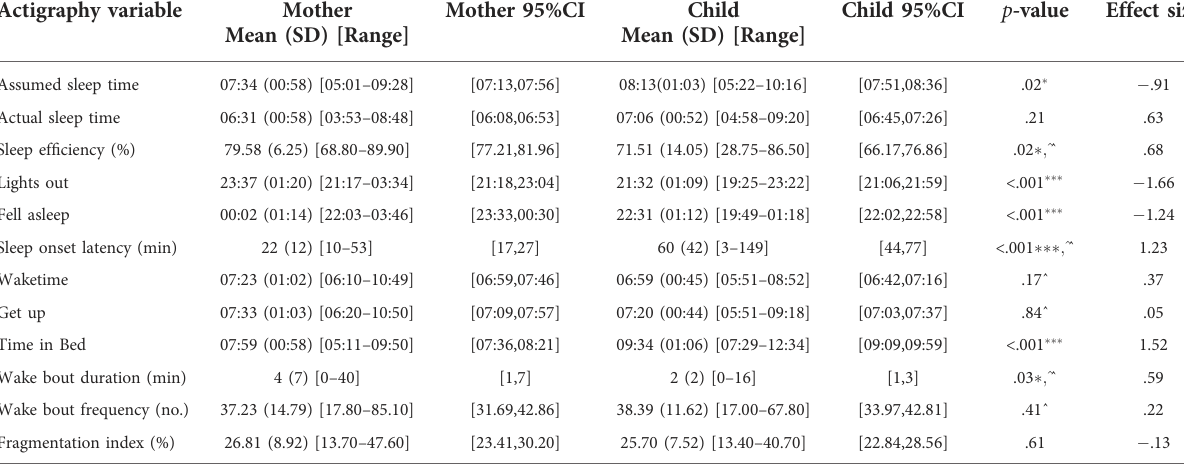
TABLE 3 Sleep pro fi les of mothers and children based on actigraphy and sleep diary data. Actigraphy